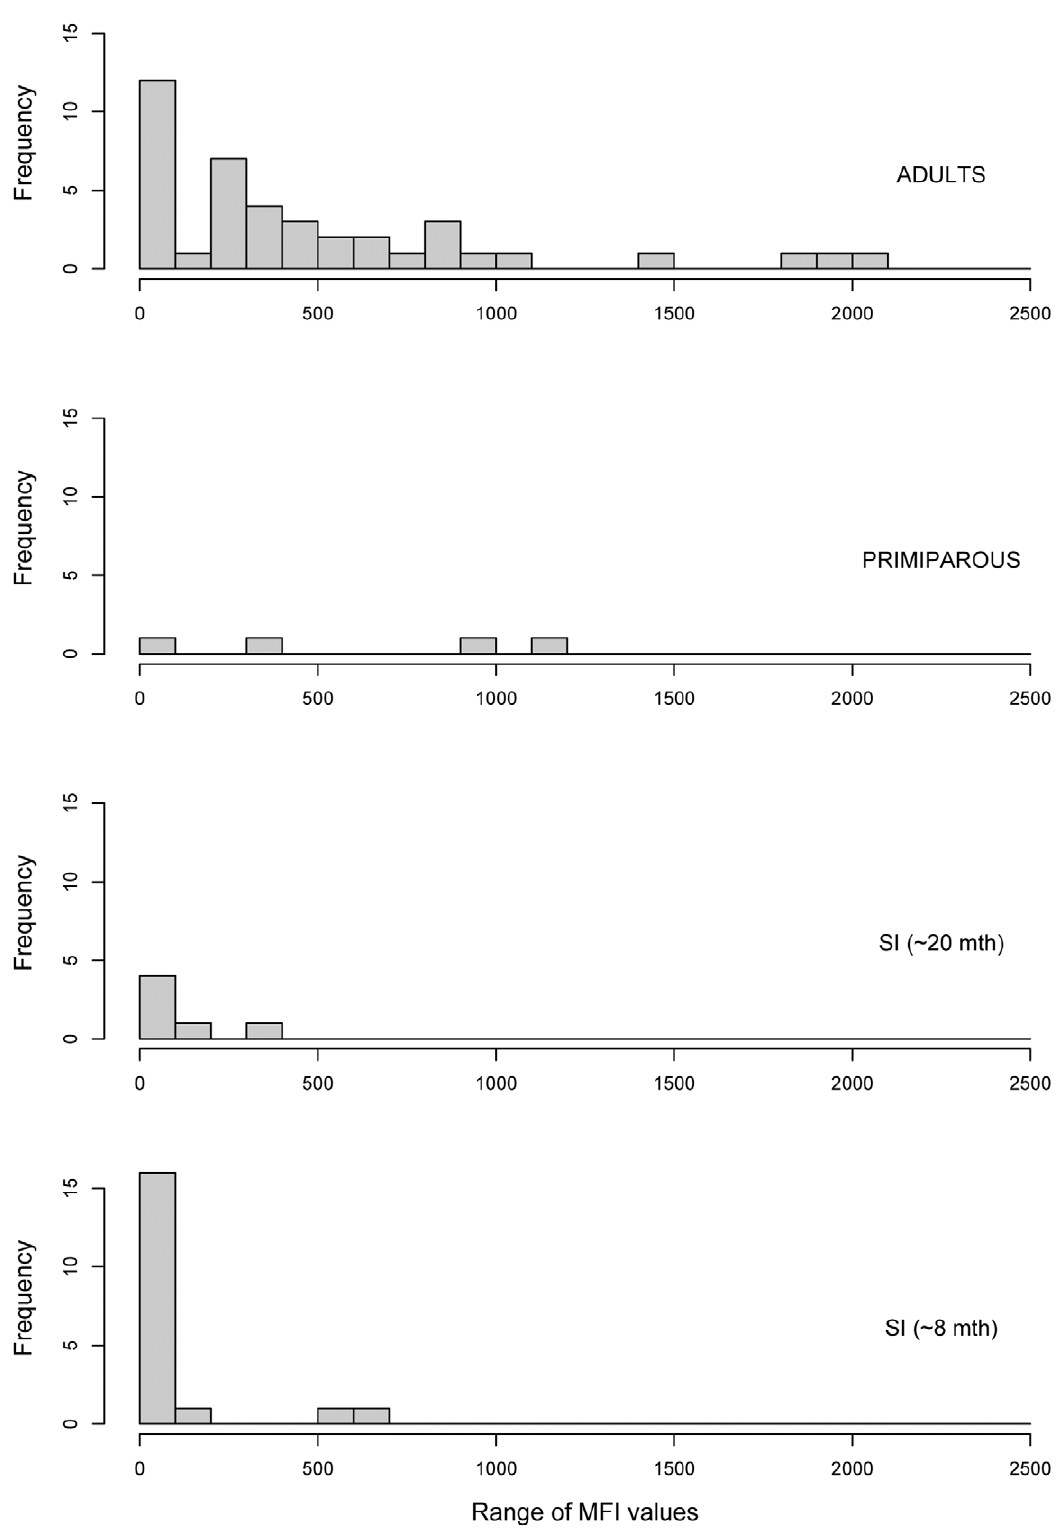
Figure 5. Frequency distribution of Luminex MFI values against NiV in Eidolonhelvumannobonensis , separated by age.